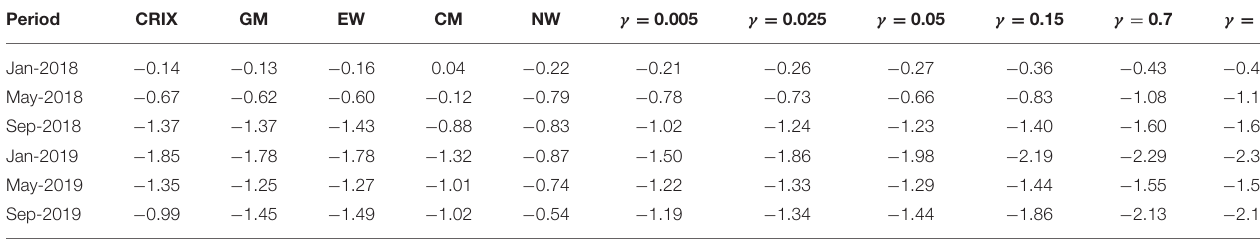
TABLE 2 | Cumulative Profits and